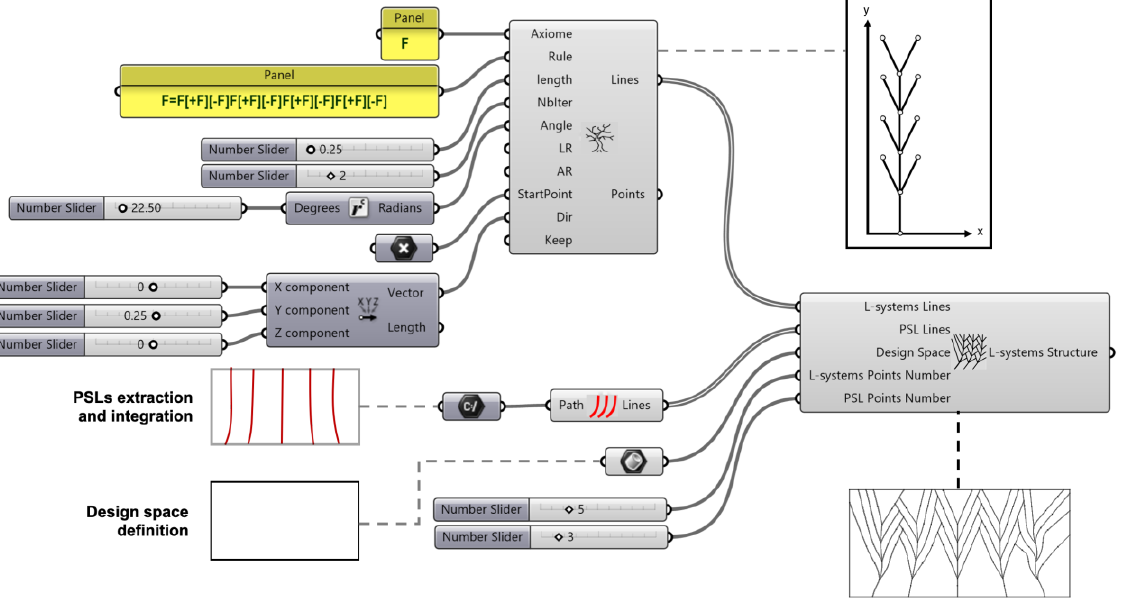
Figure 9. Grasshopper definition of the L-systems ’ construction along the PSLs ’ directions in the 2D design space.